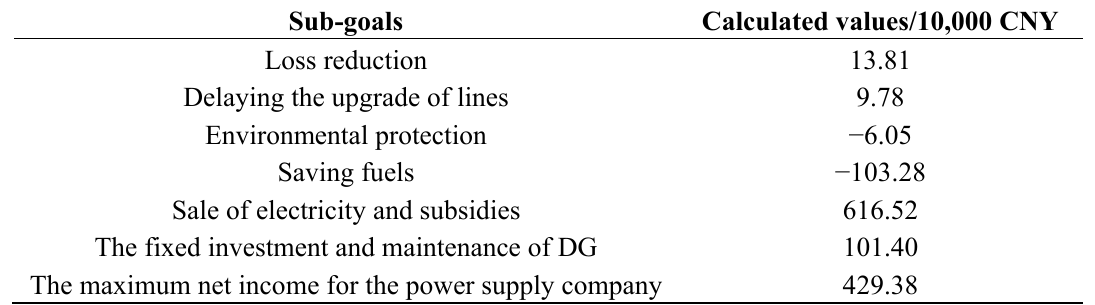
Table 6. The calculated values of each